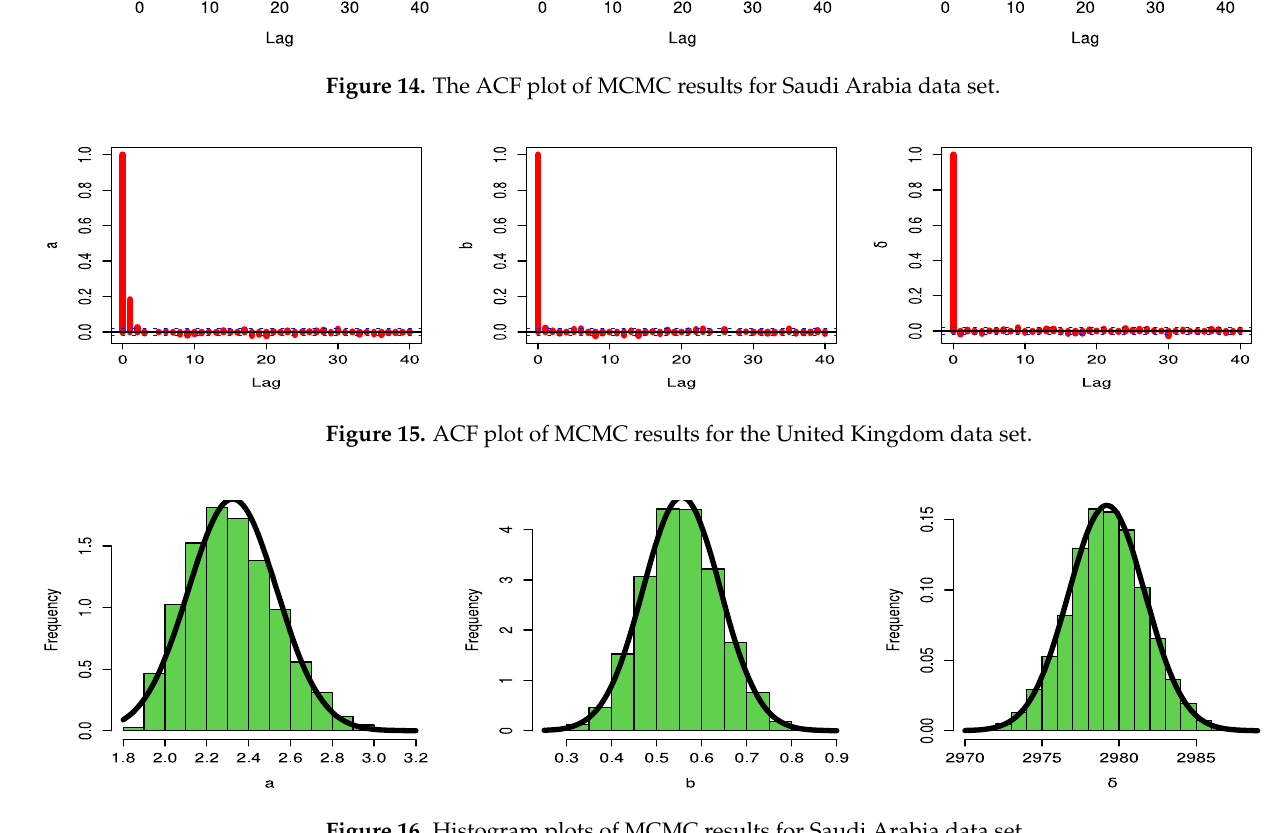
Figure 16. Histogram plots of MCMC results for Saudi Arabia data set.